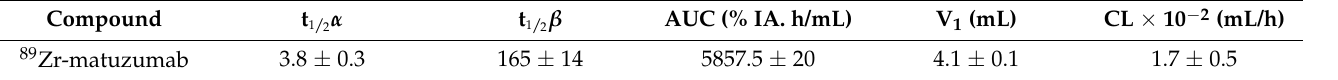
Figure 7. Pharmacokinetics of 89 Zr-matuzumab in healthy Balb-C mice. Blood values are expressed in percentage of injected activity per milliliter (% IA/mL) and were used to generate pharmacoki- netic parameters. Table 1. Pharmacokinetic parameters of 89 Zr-matuzumab ± SD.